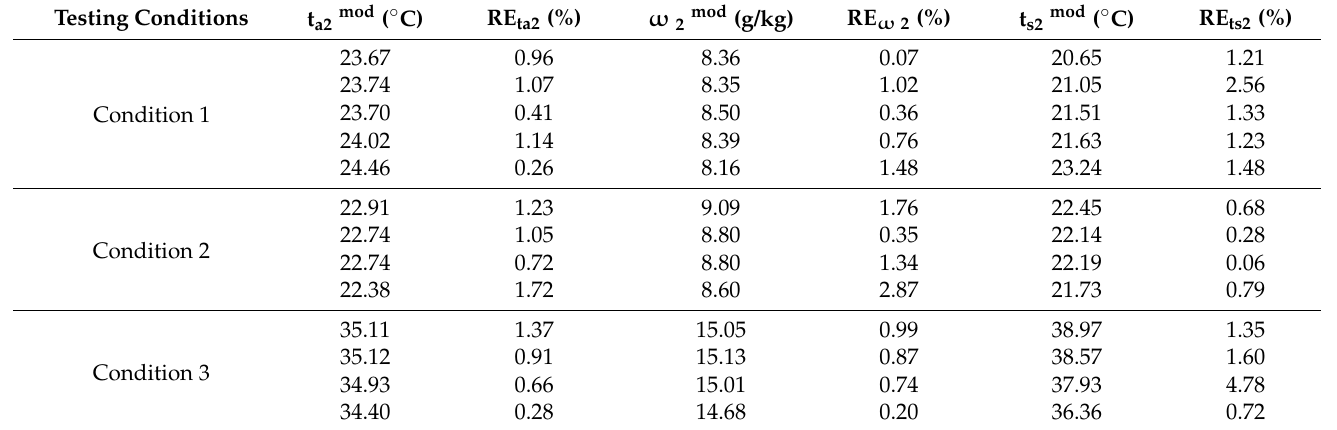
Table 3. Comparison between experimental and theoretical results.